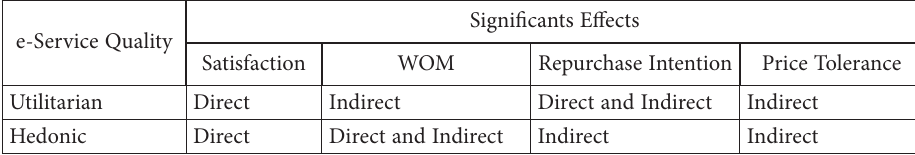
Table 8. Direct and indirect effects of utilitarian and hedonic quality (full model and segment models)